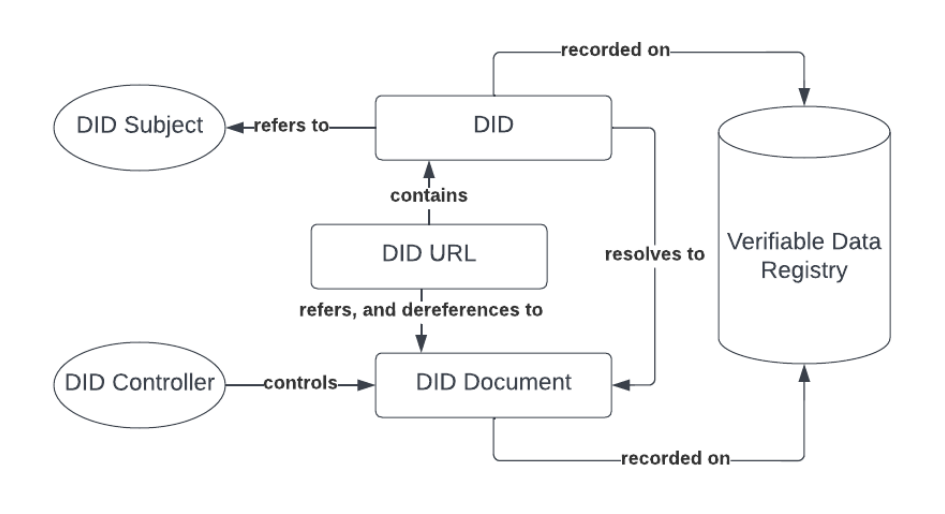
Figure 3. Decentralized identifier architecture [1].